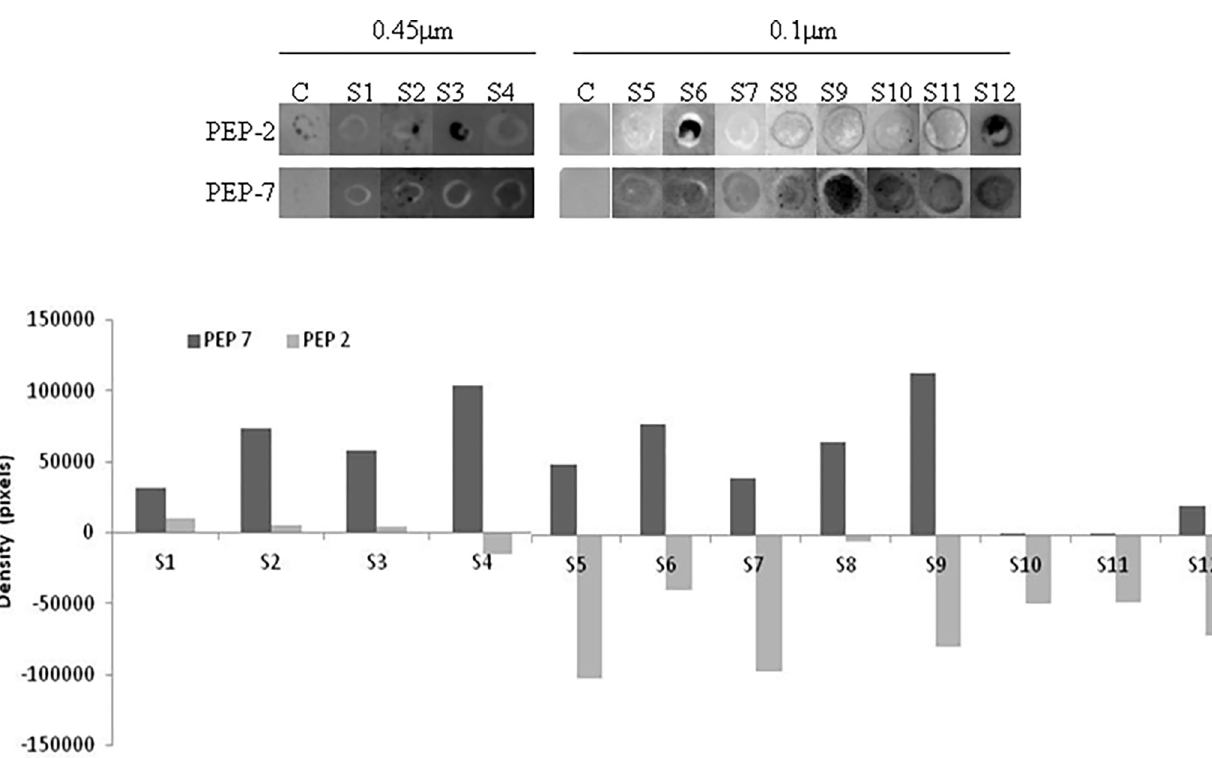
Fig 4. Recognition of Pep2 and Pep7 of LruC protein by sera from leptospirosis patients. Nitrocellulose membranes (0.45 or 0.1 μ m) of Dot Blot assay exhibiting the interaction of the selected peptides and the sera of leptospirosis patients (S1 to 12) and control (C), is shown in the top figure. The graphic represents the density of chemiluminescent signals resulting of Pep2 and Pep7 incubated with serum from different leptospirosis patients quantified using ImageJ software.